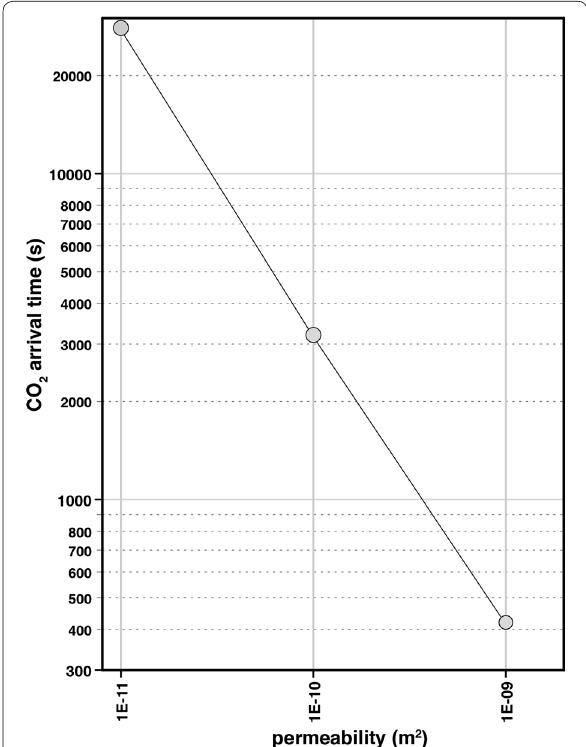
Fig. 10 CO 2 travel-times plotted as functions of permeability. The gas pulse originates at 800 m depth which marks the VLP source location which is inferred to be the boundary between the magma supply zone and the hydrothermal